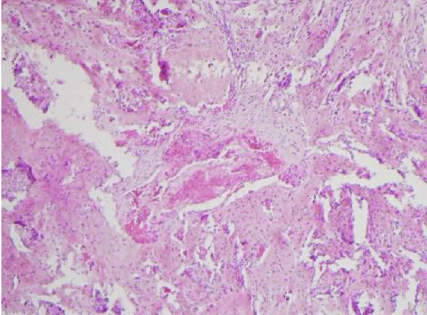
Figure 5: Small cystic hemorrhagic area associated with fl orid reactive bone formation within the cyst wall in subperiosteal ABC (H&E, 4x).